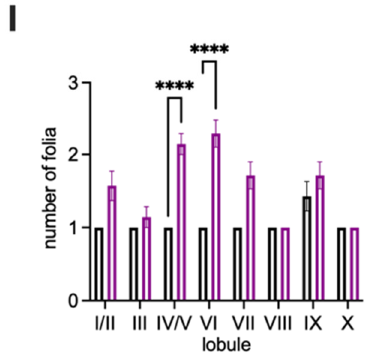
Figure 2. Male BTBR mice show vermal enlargement and foliation that varies by lobule. ( A ) Brain weight is comparable between strains. ( B ) Representative image of gross anatomical differences between C57 (left) and BTBR (right) sagittal vermis sections. Arrows identify additional lobules in the BTBR section. ( C ) Area of the midline vermal section is significantly larger in BTBR mice. ( D ) Molecular cell layer (MCL) and granule cell layer (GCL) are significantly enlarged in the BTBR vermis. ( E ) The number of folia in the vermis is significantly different in BTBR mice. ( F ) Enlargement of vermis area in BTBR mice depends on lobule. ( G ) Enlargement of area of the molecular cell layer in BTBR mice depends on lobule. ( H ) Enlargement of area of the granule cell layer in BTBR mice depends on lobule. ( I ) Abnormal foliation in BTBR mice depends on lobule. Black, C57B6/J mice; purple, BTBR mice. Error bars denote standard error of the mean. Asterisks denote significant results from two-sample t -tests ( A – E ) or planned comparisons following a significant two-way ANOVA ( F – I ). *, p < 0.05; **, p < 0.01; ***, p < 0.001; ****, p < 0.0001.